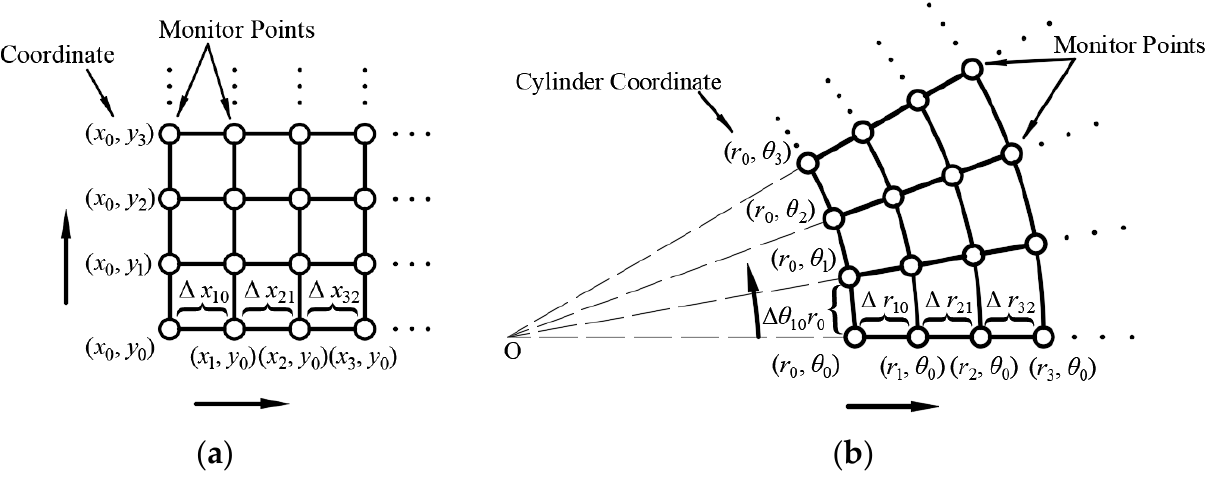
Figure 1. Layout of monitoring points in the coordinate systems: ( a ) in the Cartesian system; ( b ) in the Cylinder system.